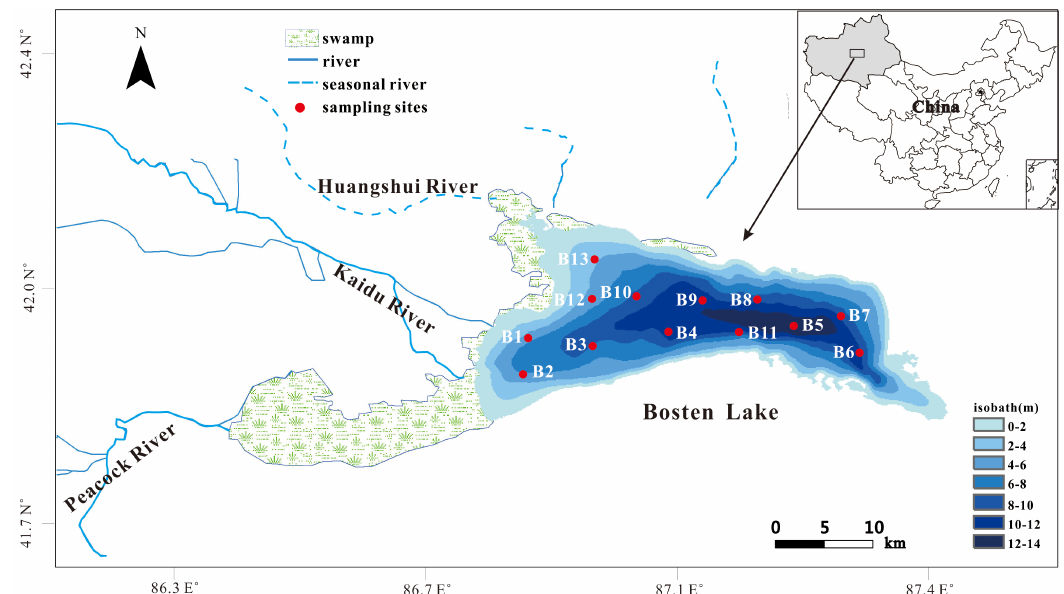
Figure 1. Map of Bosten Lake with the water depth and the 13 sampling stations (red dotes). Bathymetry was measured in 2008 by Wu et al. (2013) and bathymetric contours were plotted by using software ArcGIS 9.3 and CorelDraw